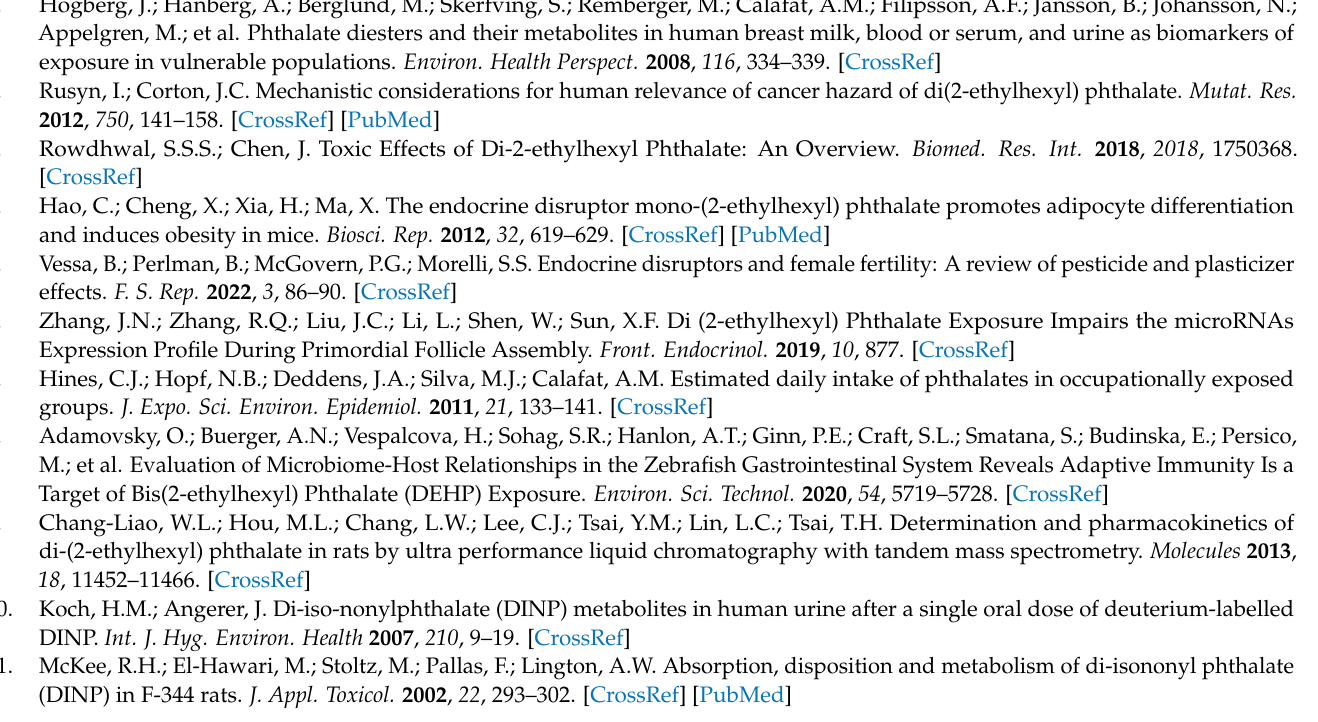
Table S2: Primers sequences for real-time PCR on gene expressions in Raw 264.7; Table S3: Relative quantification ( ± SEM) of gene expressions in HT-29 after treatment of DEHP fermenter extracts; Table S4: Relative quantification ( ± SEM) of gene expressions in HT-29 after treatment of DINP fermenter extracts; Table S5: Relative quantification ( ± SEM) of gene expressions in RAW 264.7 after treatment of DINP fermenter